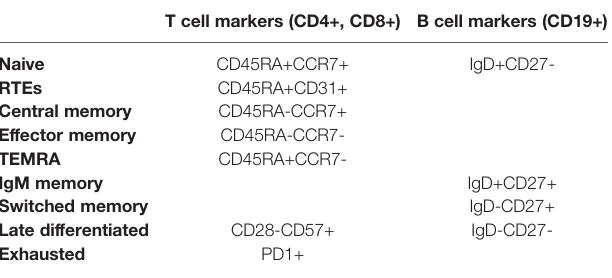
TABLE 1 | Phenotype of T and B cells